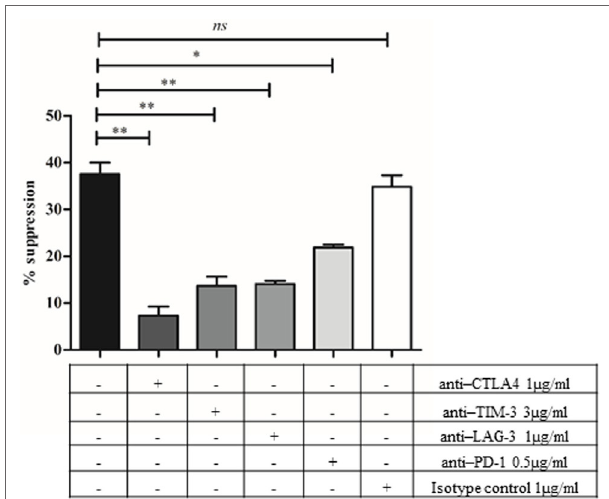
FigUre 9 | Checkpoint inhibitory molecules are involved in the suppressive activity of CD8 + human leukocyte antigen–antigen D related (HLADR) + CD28 + T cells. CFSE-labeled peripheral blood mononuclear cells (PBMCs) were analyzed following a 4 days co-culture after stimulation with anti-CD3 (1 µg/ ml) and anti-CD28 (0.5 µg/ml) in the absence or presence of anti-cytotoxic T-lymphocyte-associated antigen 4 (1 µg/ml), anti-T cell immunoglobulin and mucin protein-3 (3 µg/ml), anti-lymphocyte activation gene-3 (1 µg/ml), or anti-programmed death 1 (0.5 µg/ml). Mouse IgG1 isotype Ab was used as control. PBMCs: suppressor cell ratio of 2:1. Young donors n = 2–3 ( < 30 years); mean ± SEM, ** p < 0.001, * p < 0.05, ns, not